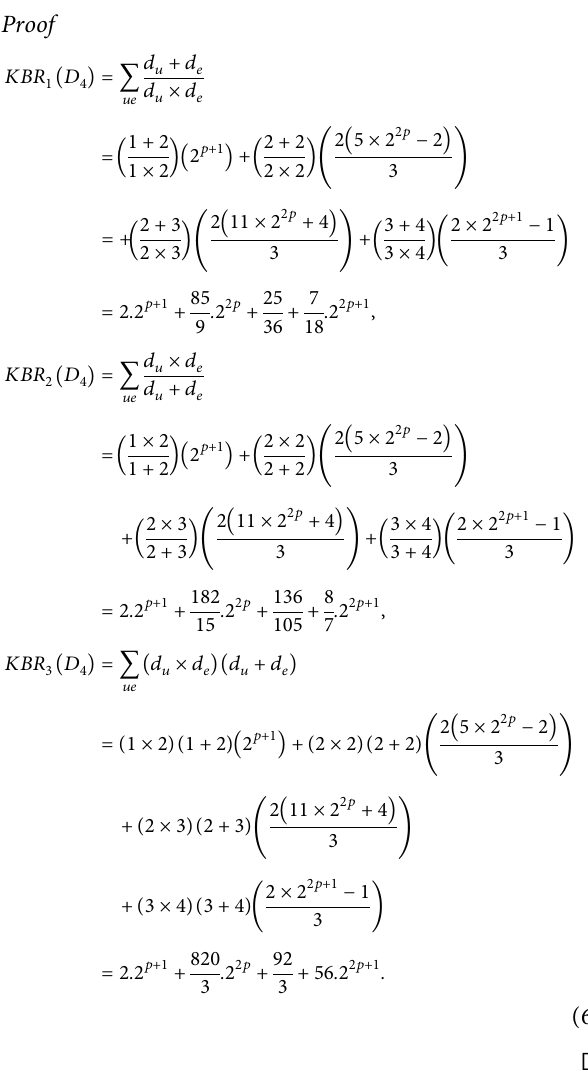
Table 5: Partition of the edges of D